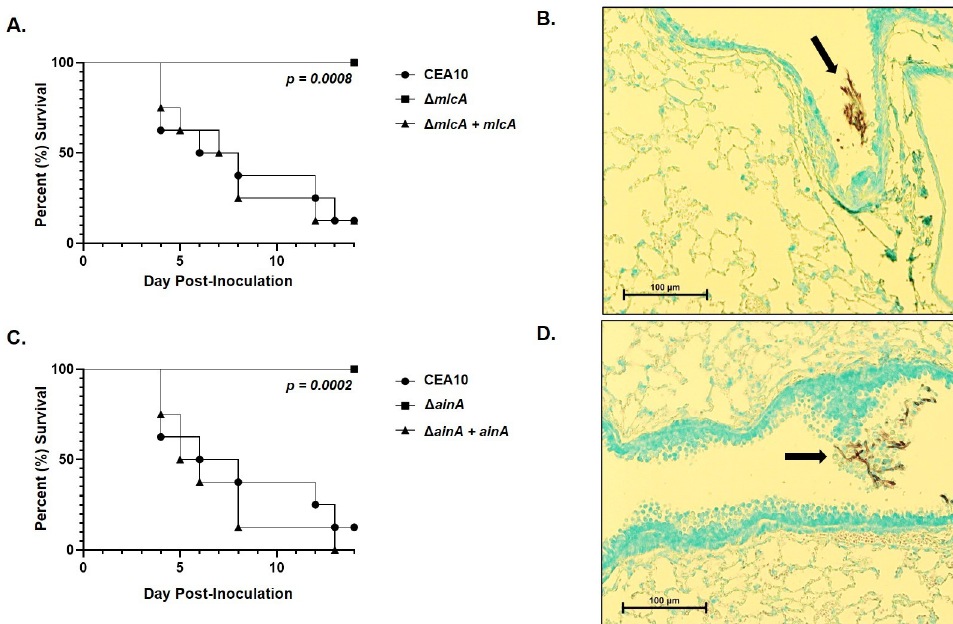
Fig 12. Loss of septation caused by deletion of mlcA or ainA results in avirulence associated with lack of tissue invasion. Survival analysis and GMS-stained tissue histology from immune suppressed mice infected with the Δ mlcA isogenic strain set (A) and (B) or the Δ ainA isogenic strain set (C) and (D) , respectively. Mice (n = 8 / strain) were immune suppressed with a single, subcutaneous injection of triamcinolone acetonide (40 mg/kg) on Day -1. On Day 0, all mice were intranasally administered 100,000 conidia suspended in 20 μ l of sterile saline. No deaths were recorded in sham treated mice (sterile saline alone, n = 8). Statistical comparisons were made by Mantel-Cox log-rank test. Black arrows denote non-invasive fungal growth identified only in the airways of Δ mlcA and Δ ainA infected mice.